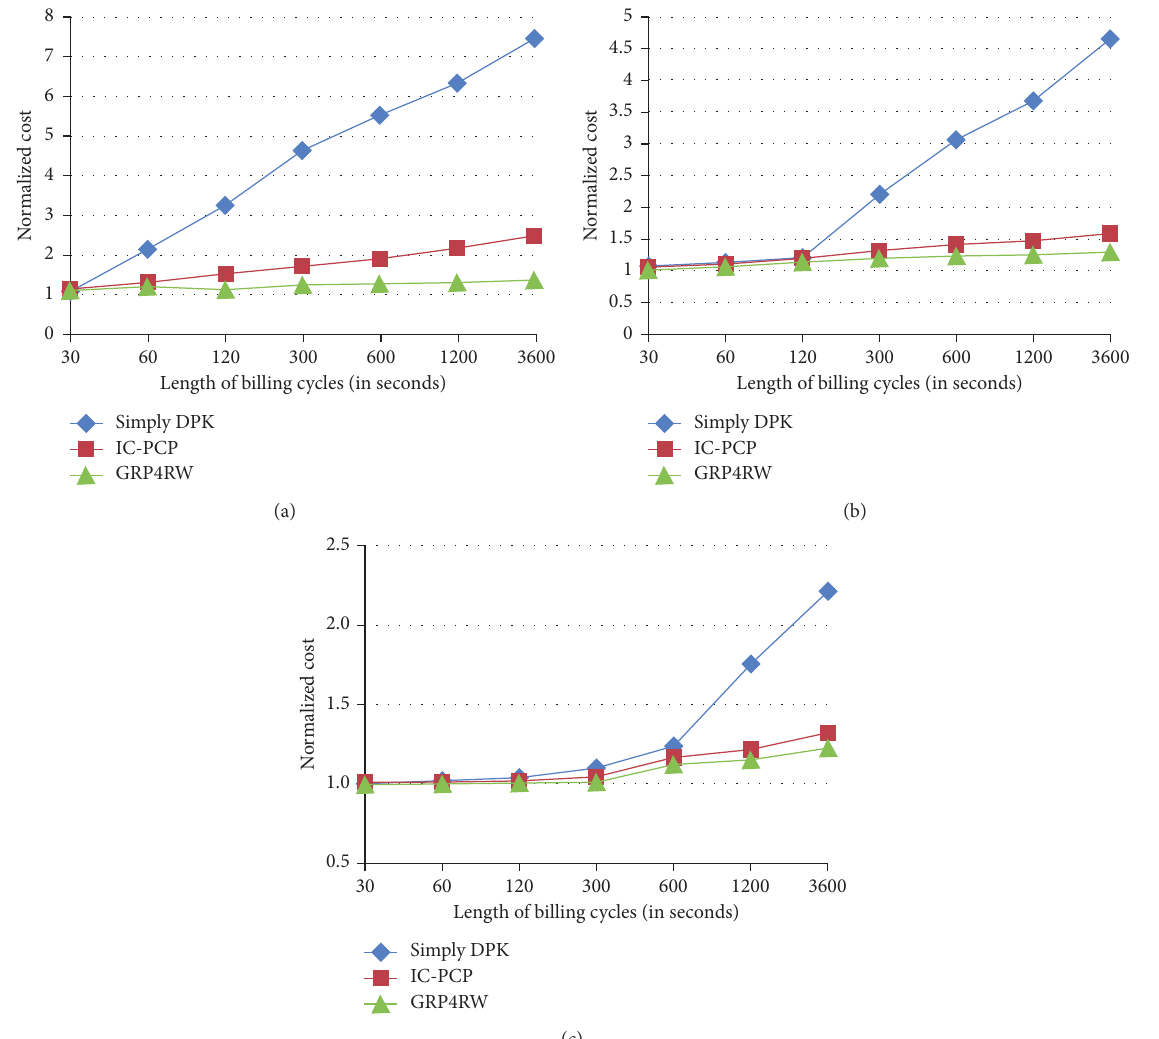
Figure 7: The Length of billing cycles impact on algorithms. (a) Workflow with small workload. (b) Workflow with medium workload. (c) Workflow with large